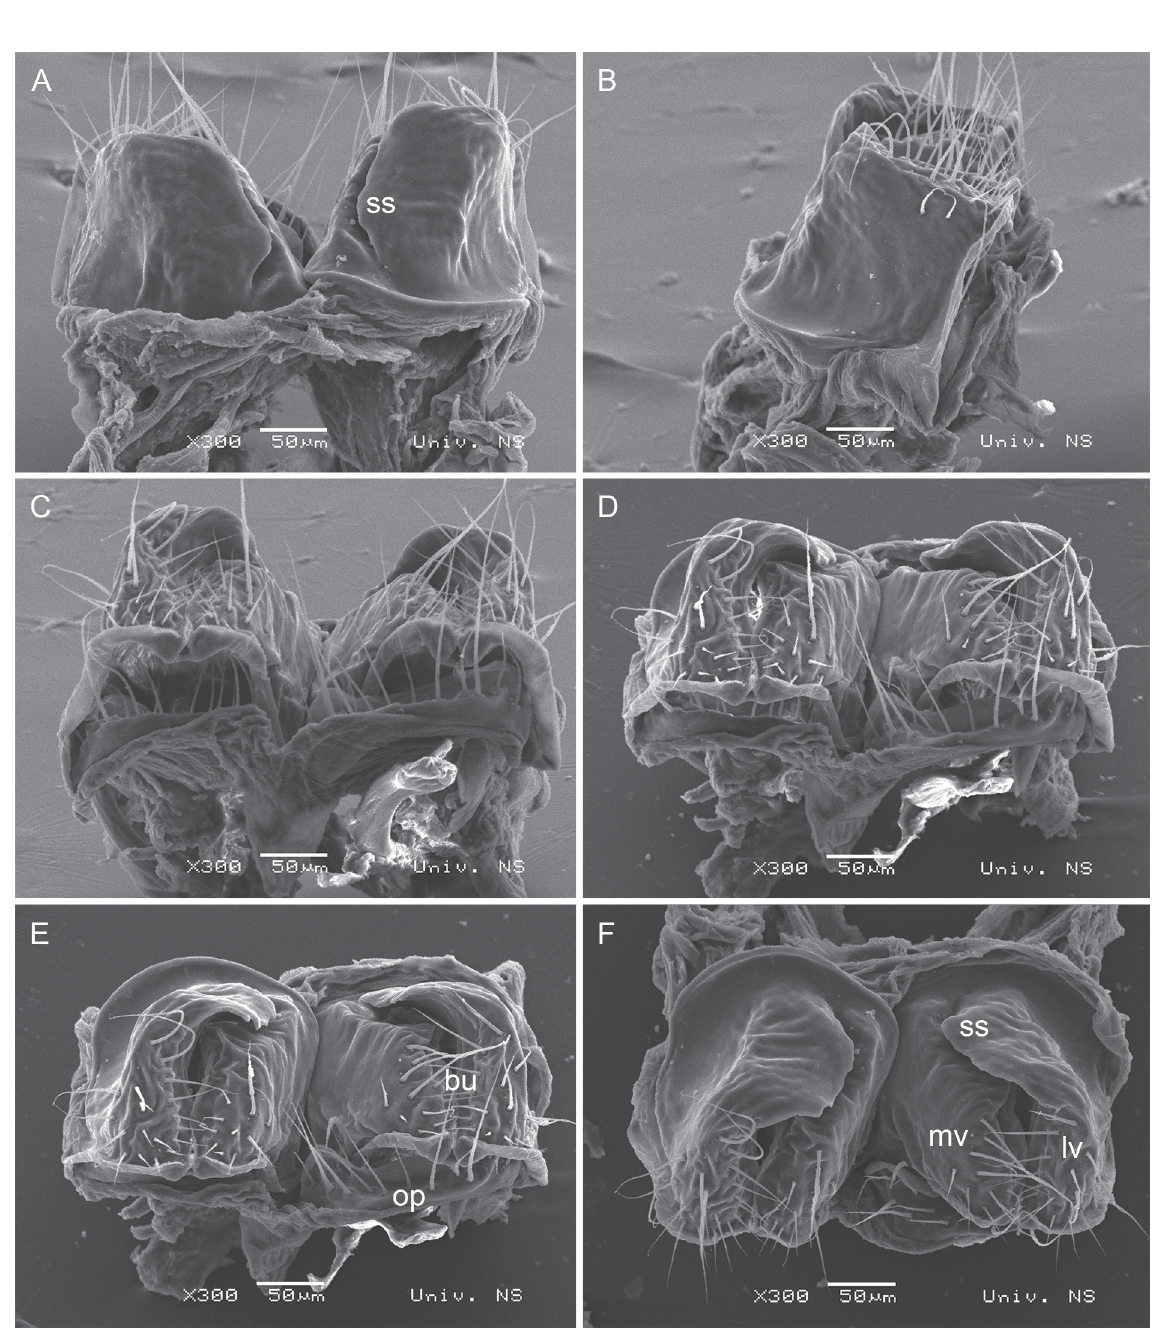
Fig. 8. Biokoviella mosorensis Antić & Dražina sp. nov., ♀, paratype, vulvae. A . Posterior view. B . Lateral view. C . Anterior view. D . Antero-distal view. E . Distal view. F . Postero-distal view. Abbreviations: see Material and